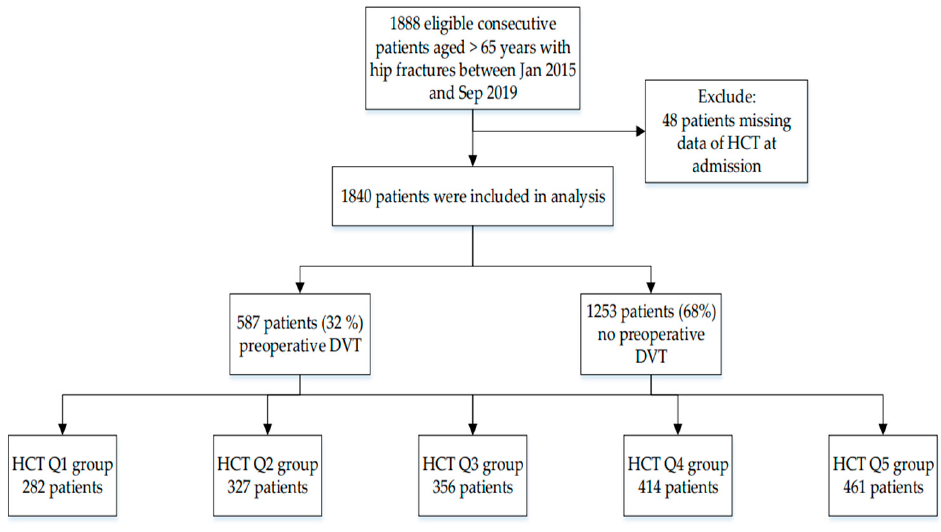
Figure 2. Study flow diagram.